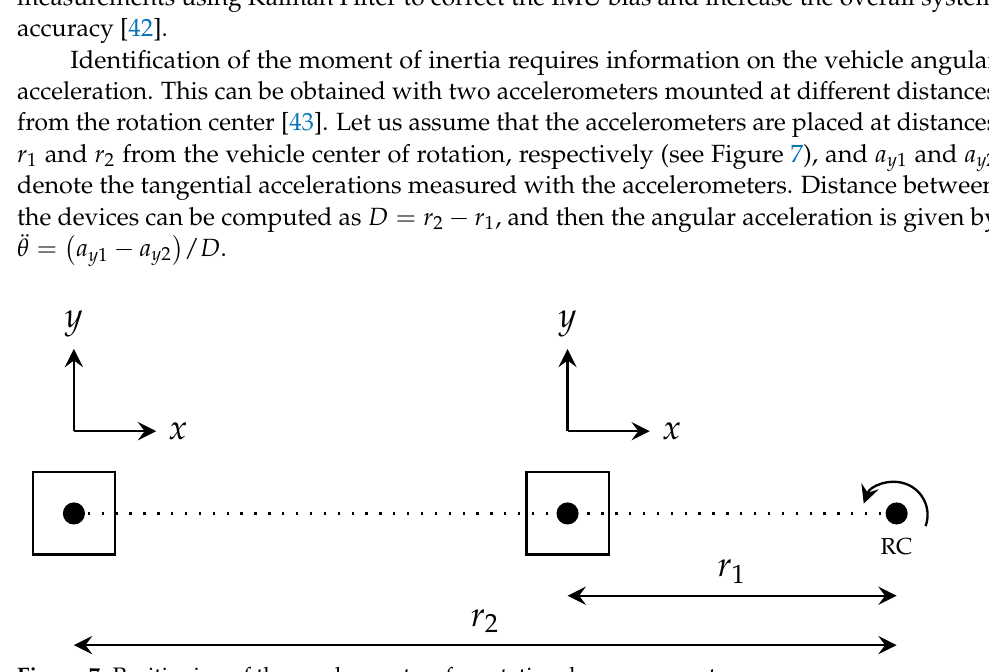
Figure 7. Positioning of the accelerometers for rotational